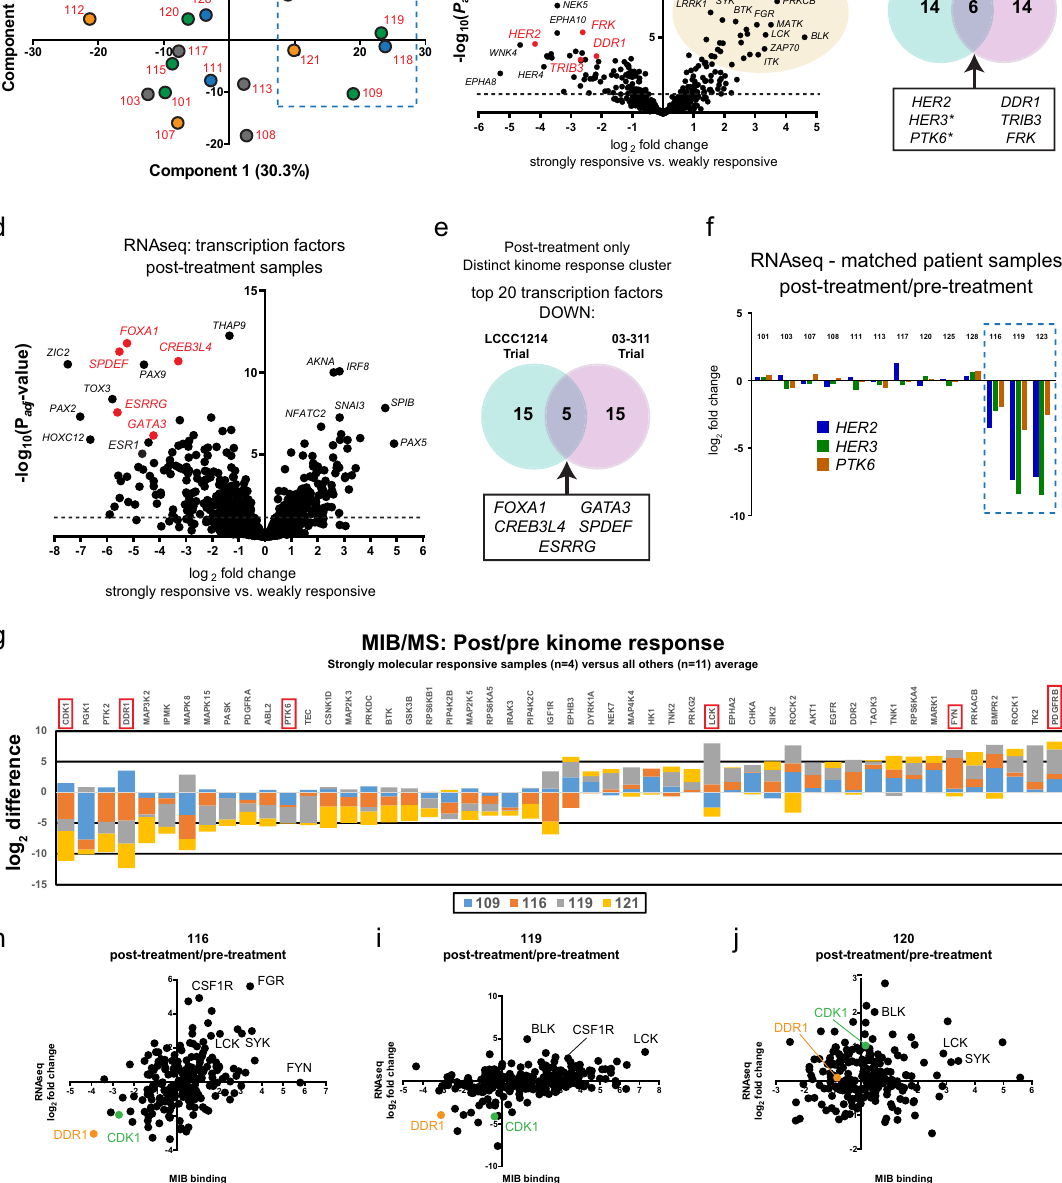
top 20 kinases DOWN: